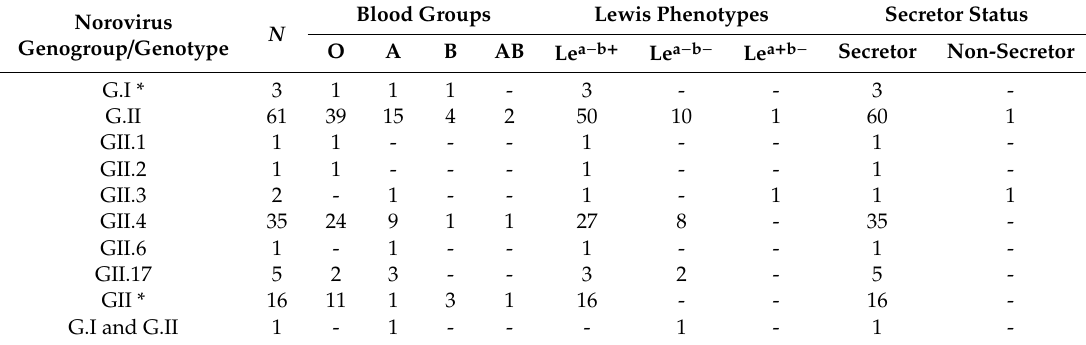
Table 4. Distribution of histo-blood group antigen phenotypes in relation to noroviruses genogroup and genotypes among children infected with noroviruses in Esp í rito Santo state, Brazil.